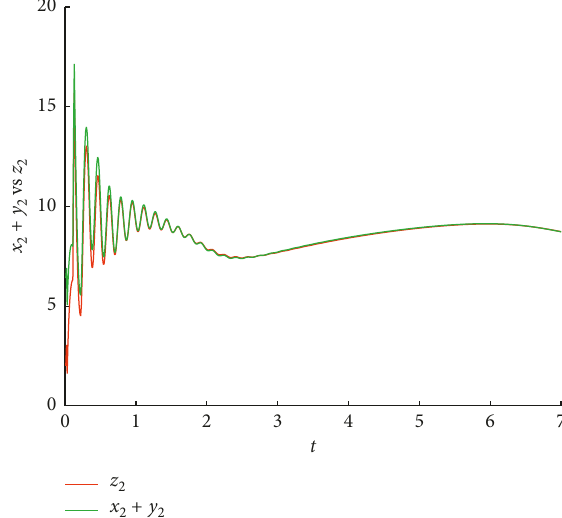
Figure 8: Time responses for state x